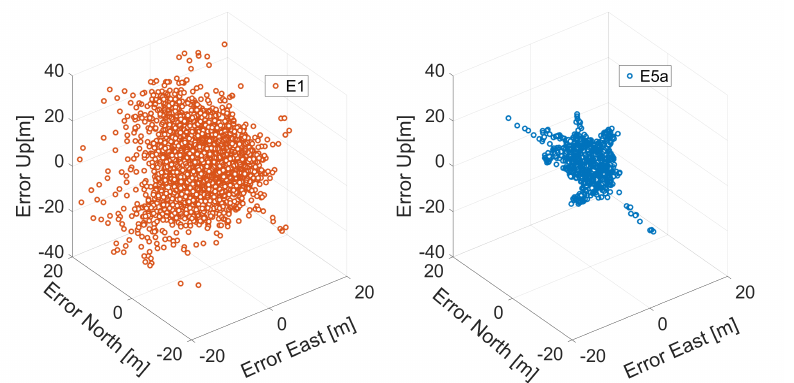
Figure 14. Three-dimensional coordinate error scatter plots for Galileo single point positioning of Xiaomi Mi 9. The left panel presents an E1-based solution, and the right panel corresponds to an E5a-based